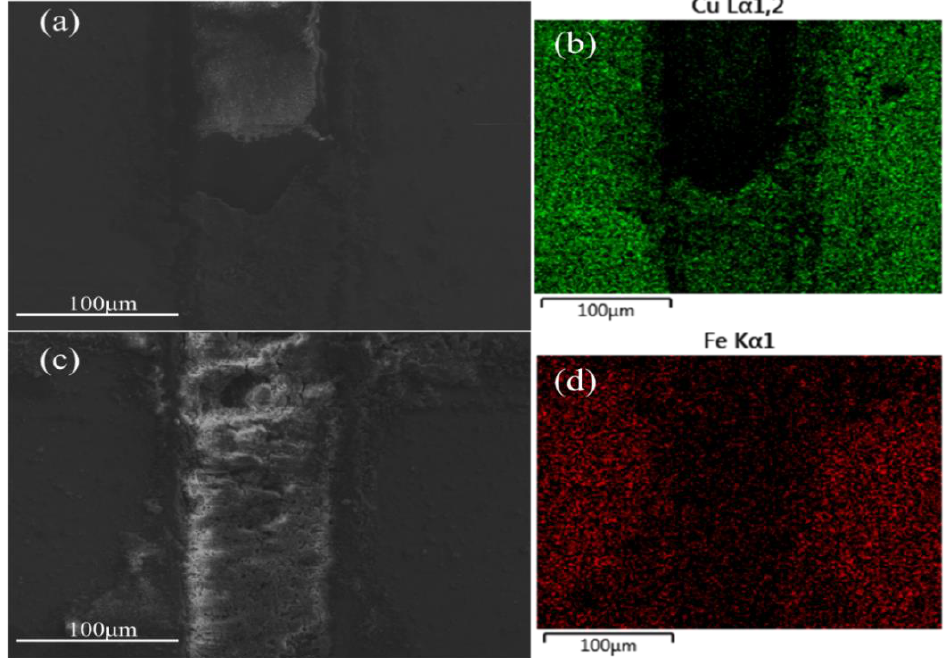
Figure 11. ( a ) Wear debris in grooves of Cu. ( b ) Elemental mapping of Cu. ( c ) Wear debris in grooves of Fe. ( d ) Elemental mapping of Fe.